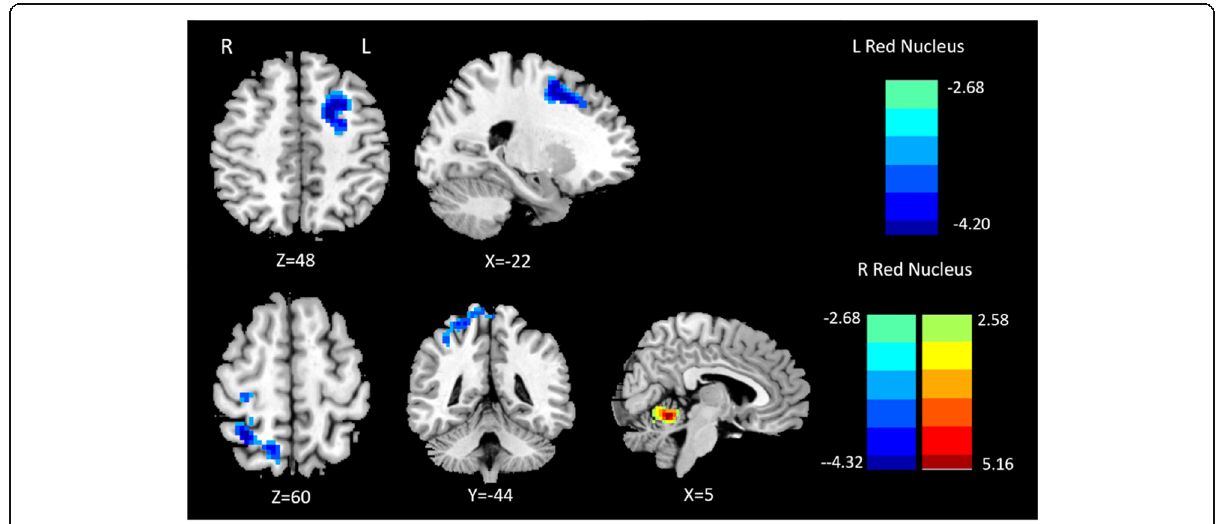
Fig. 1 Altered effective functional connectivity between the left red nucleus and whole-brain regions in patients with migraine without aura (MwoA) compared with healthy controls (first row). Altered effective functional connectivity between the right red nucleus and whole-brain regions in patients with MwoA compared with healthy controls (second row). Blue signifies decreased functional connectivity, and red denotes increased functional connectivity